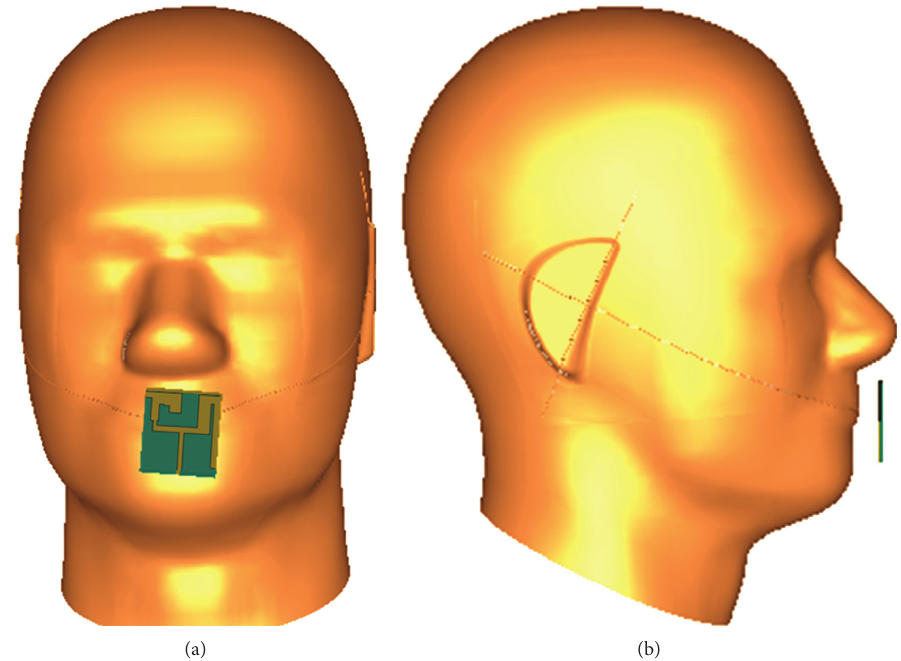
Figure 17: Position of smartwatch antenna next to SAM mouth presented by frequency bands 3.5GHz, 5.2GHz, and 5.8GHz. Figure 18 shows SAR (W/kg) distribution averaged over Based on the results shown in Table 6 and Figure 18, all the 10g inside SAM head for an antenna separation to SAM head values of the SAR averaged over 10g inside SAM head obtained mouth up to 5mm. The results of SAR distribution plots are at each frequency starting from a separation of 1mm are below higher with larger impact deep inside SAM head at the fre- the SAR limits 2 W/kg defined by the FCC standards. quency bands 2.3GHz, 2.4GHz, and 2.6GHz than the impact